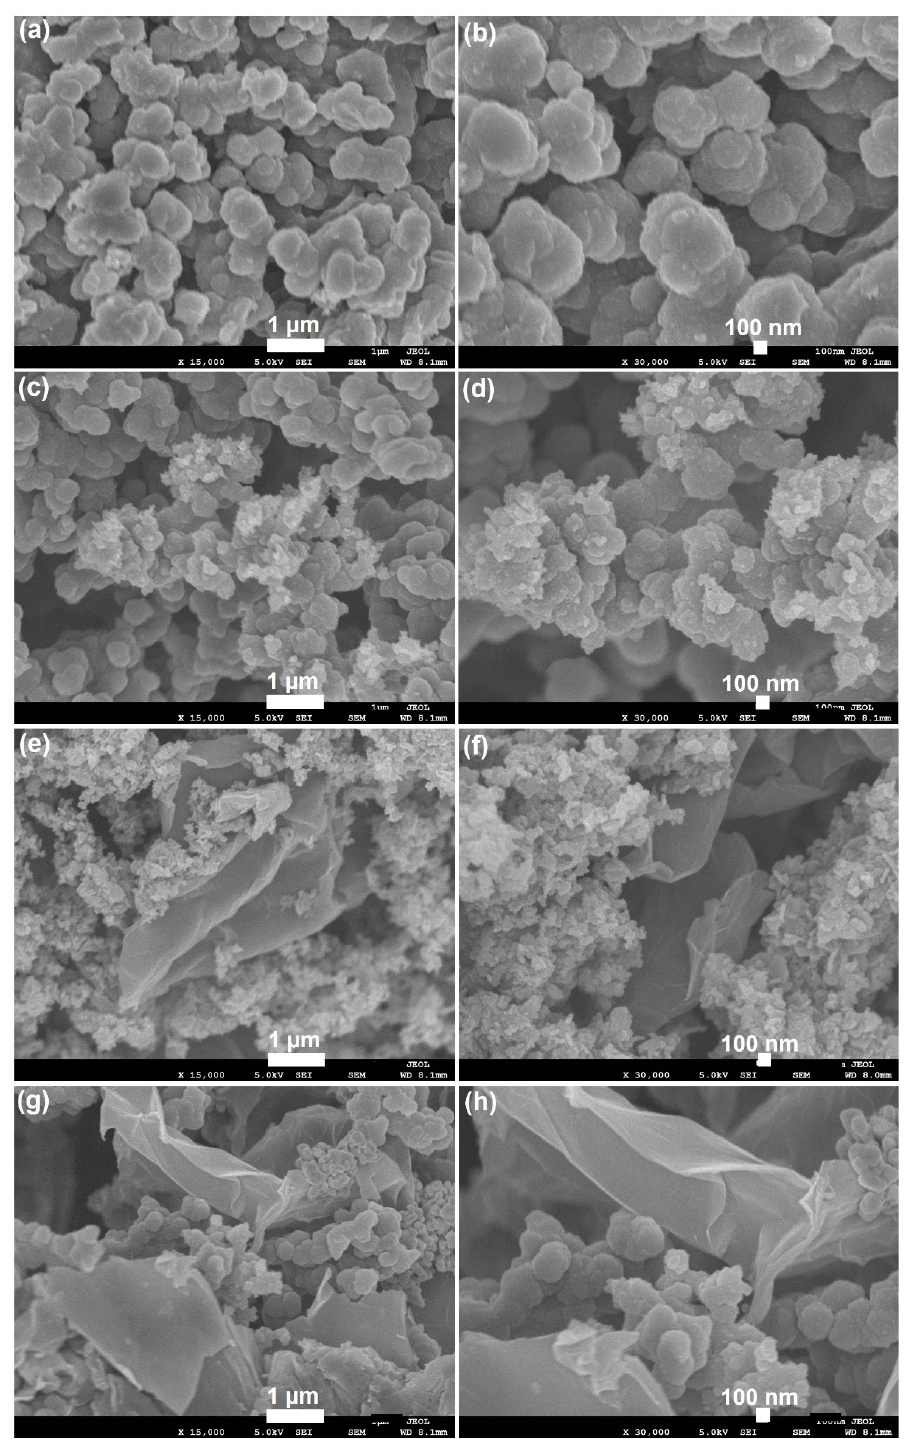
Figure 1. Low and high magnification micrographs of field emission scanning electron microscopy of PPy ( a , b ), PPy − Ni(OH) 2 ( c , d ), GN@PPy − Ni(OH) 2 ( e , f ), and Ag/GN@PPy − Ni(OH) 2 ( g , h ).